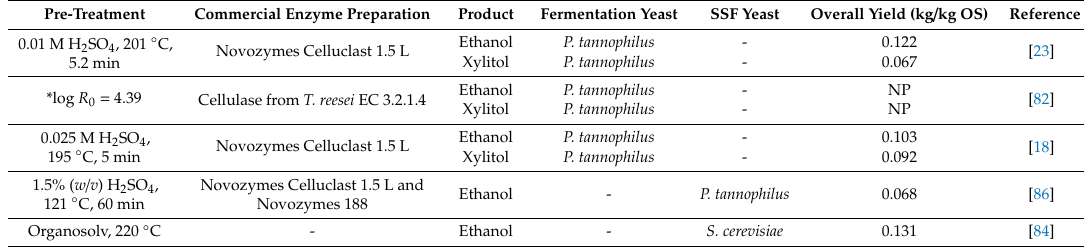
Table 7. Ethanol and xylitol yields obtained from olive stones (OS) using di ff erent process